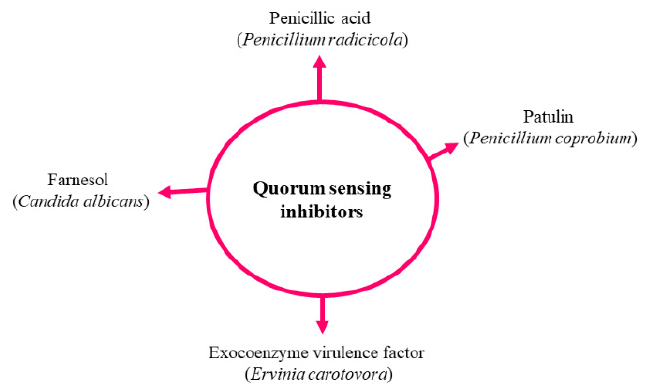
Figure 6. Reported quorum sensing inhibitors.